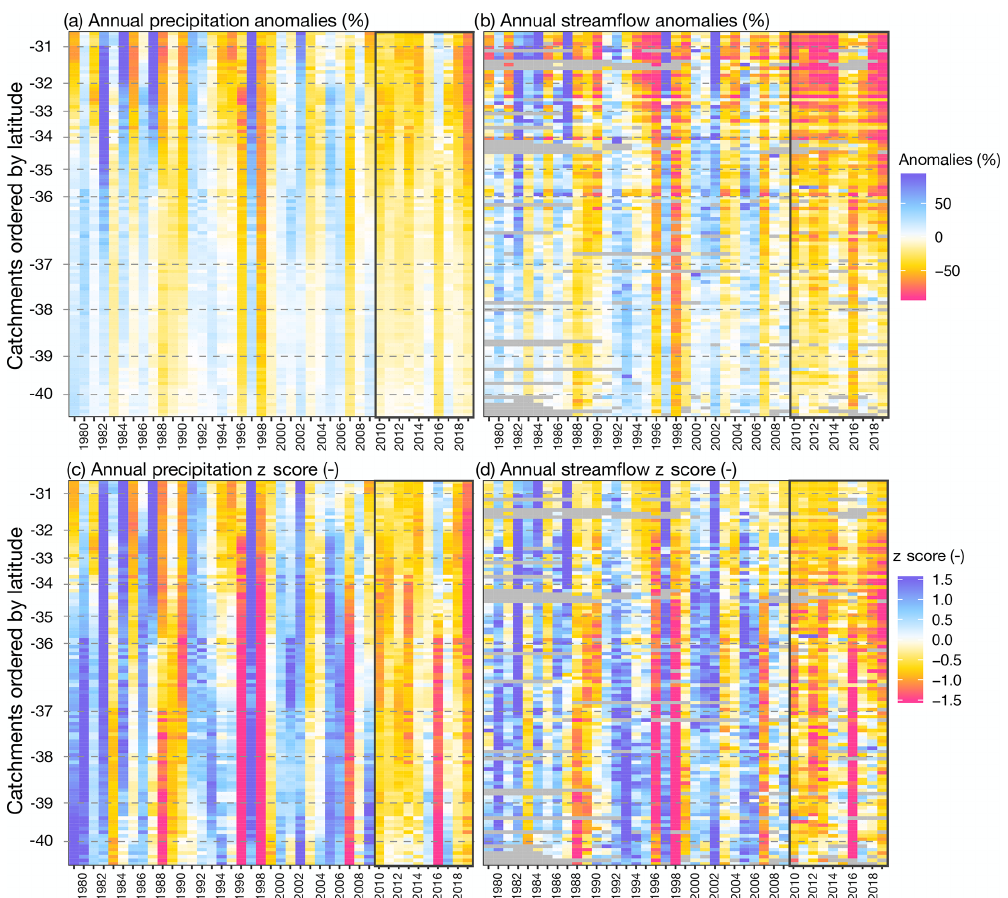
Figure 5. Relative annual anomalies of catchment-scale precipitation (a) and streamflow (b) . Panels (c) and (d) present the z score of annual precipitation and streamflow. The MD period (April 2010 to March 2020) is highlighted by a grey box. Each row in the heat maps corresponds to one study catchment, and the catchments are sorted from north to south to illustrate regional drought